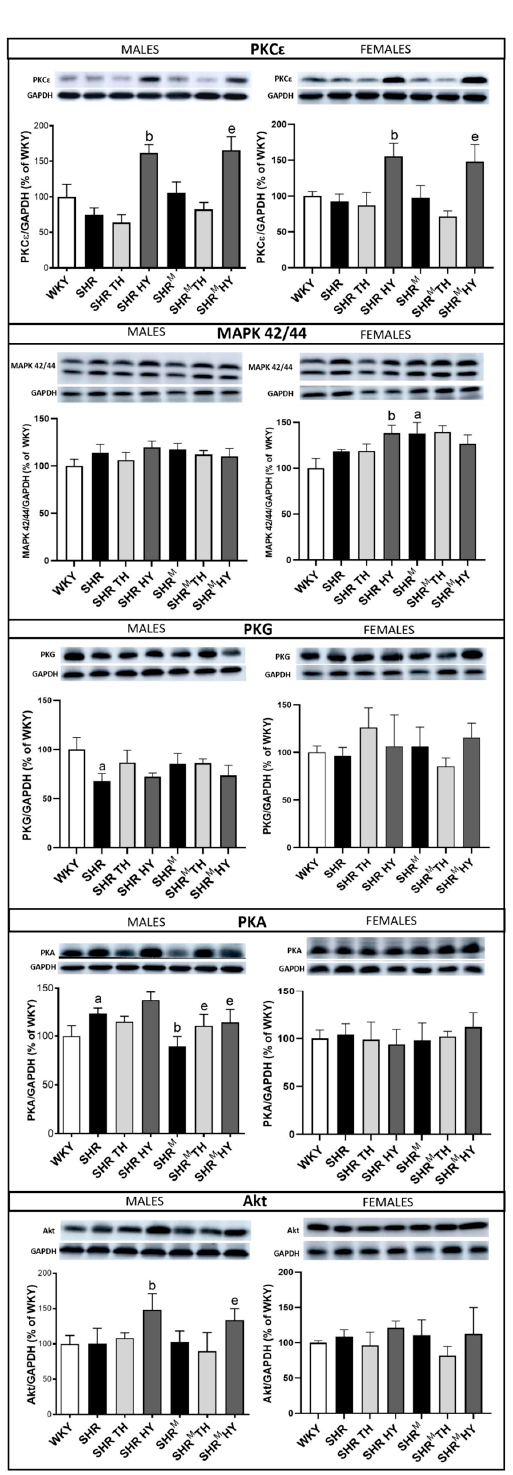
Figure 9. Myocardial levels of the Cx43 interacting protein kinases assessed by Western blotting. Note an increase of PKC ε in hairless SHR M males compared to the wild type strain, as well as in response to a hypothyroid status, regardless of the strain and sex. WKY—Wistar Kyoto normotensive control rats, SHR—wild type spontaneously hypertensive rats, TH—hyperthyroid rats, HY—hypothyroid rats and SHR M —hairless spontaneously hypertensive rats, n = 5 per group. Data are presented as means ± SD, a p < 0.05 vs. WKY, b p < 0.05 vs. SHR and e p < 0.05 vs. SHR M . One-way ANOVA and Bonferroni’s multiple comparison test were used as the statistical method.